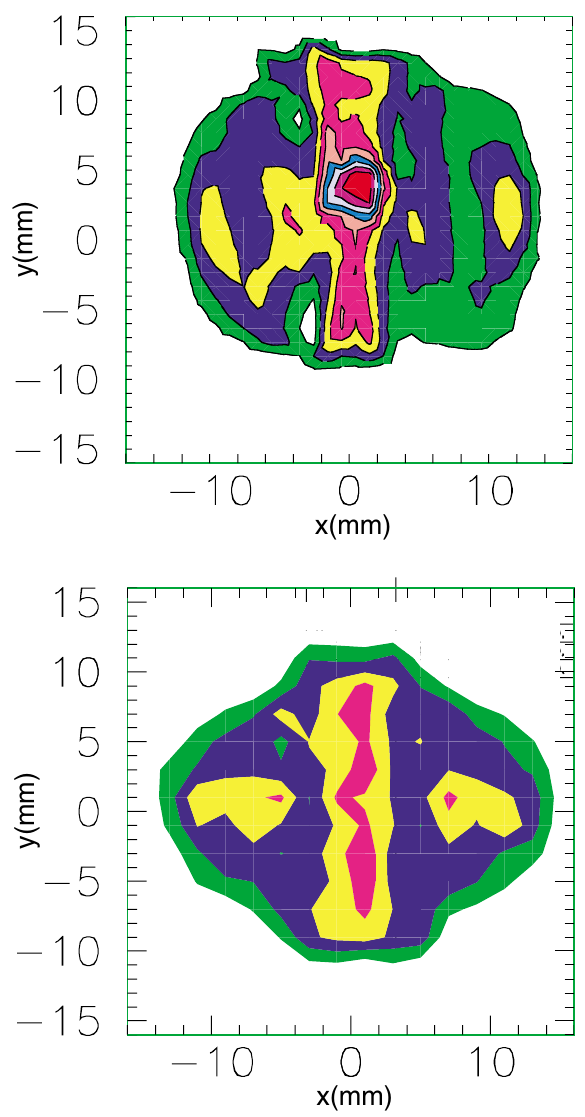
FIG. 7. (Color) Data (top panel) compared to PIC simulation (bottom panel) of the crossed-slit measurement at the d 3 diagnostic station. The contour lines for the experimental data indicate 10% increments in relative intensity (20% con- tours for the PIC simulation) and the color code sequence from lowest to highest intensity is green, blue, yellow, pink, . . . ,